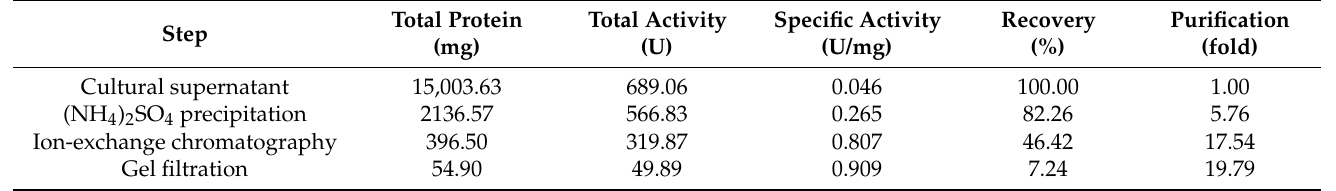
Table 2. Purification of B. amyloliquefaciens TKU050